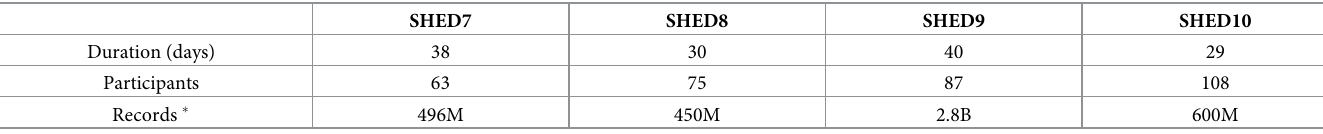
Table 1. Datasets